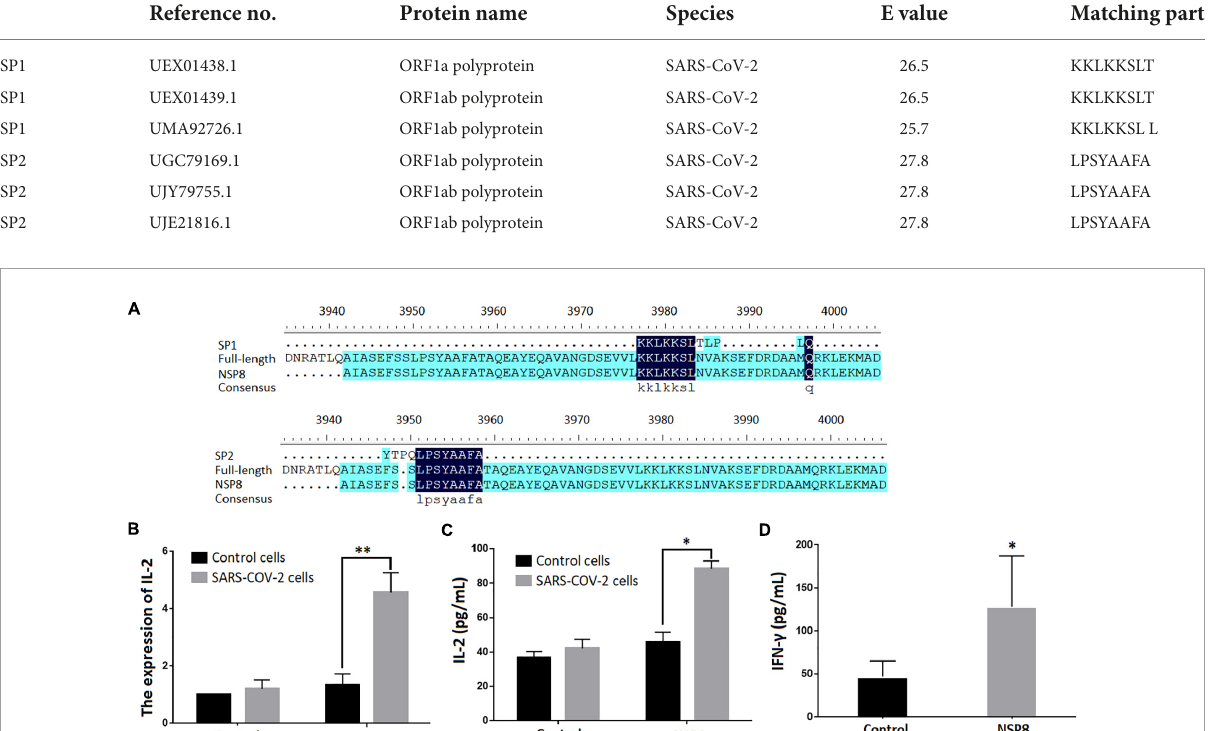
TABLE 5 BLAST analysis of epitope peptide candidates.